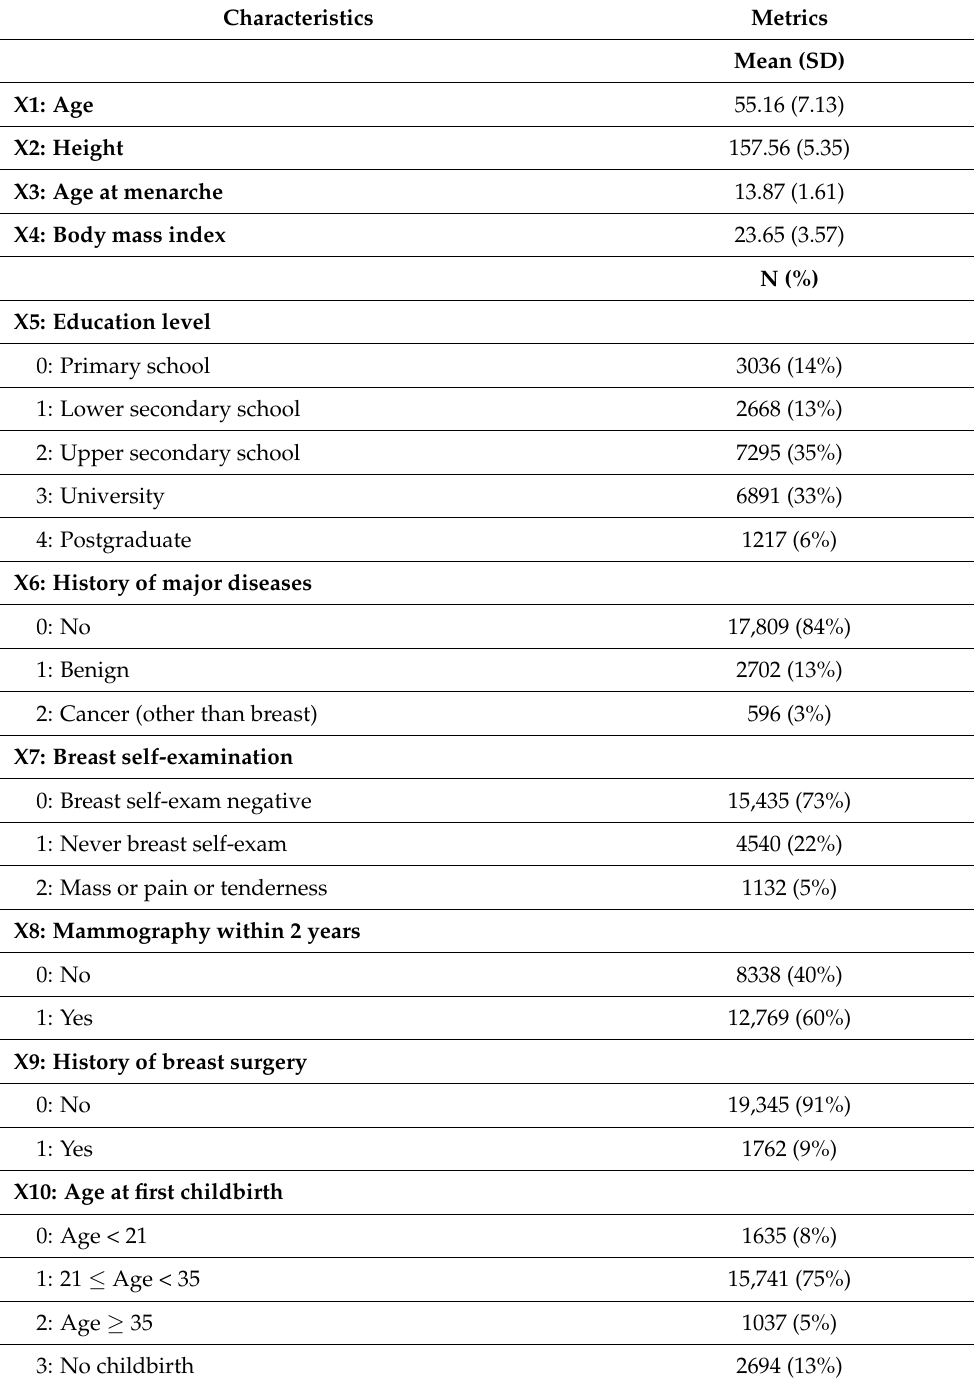
Table 1. Demographic and clinical characteristics of